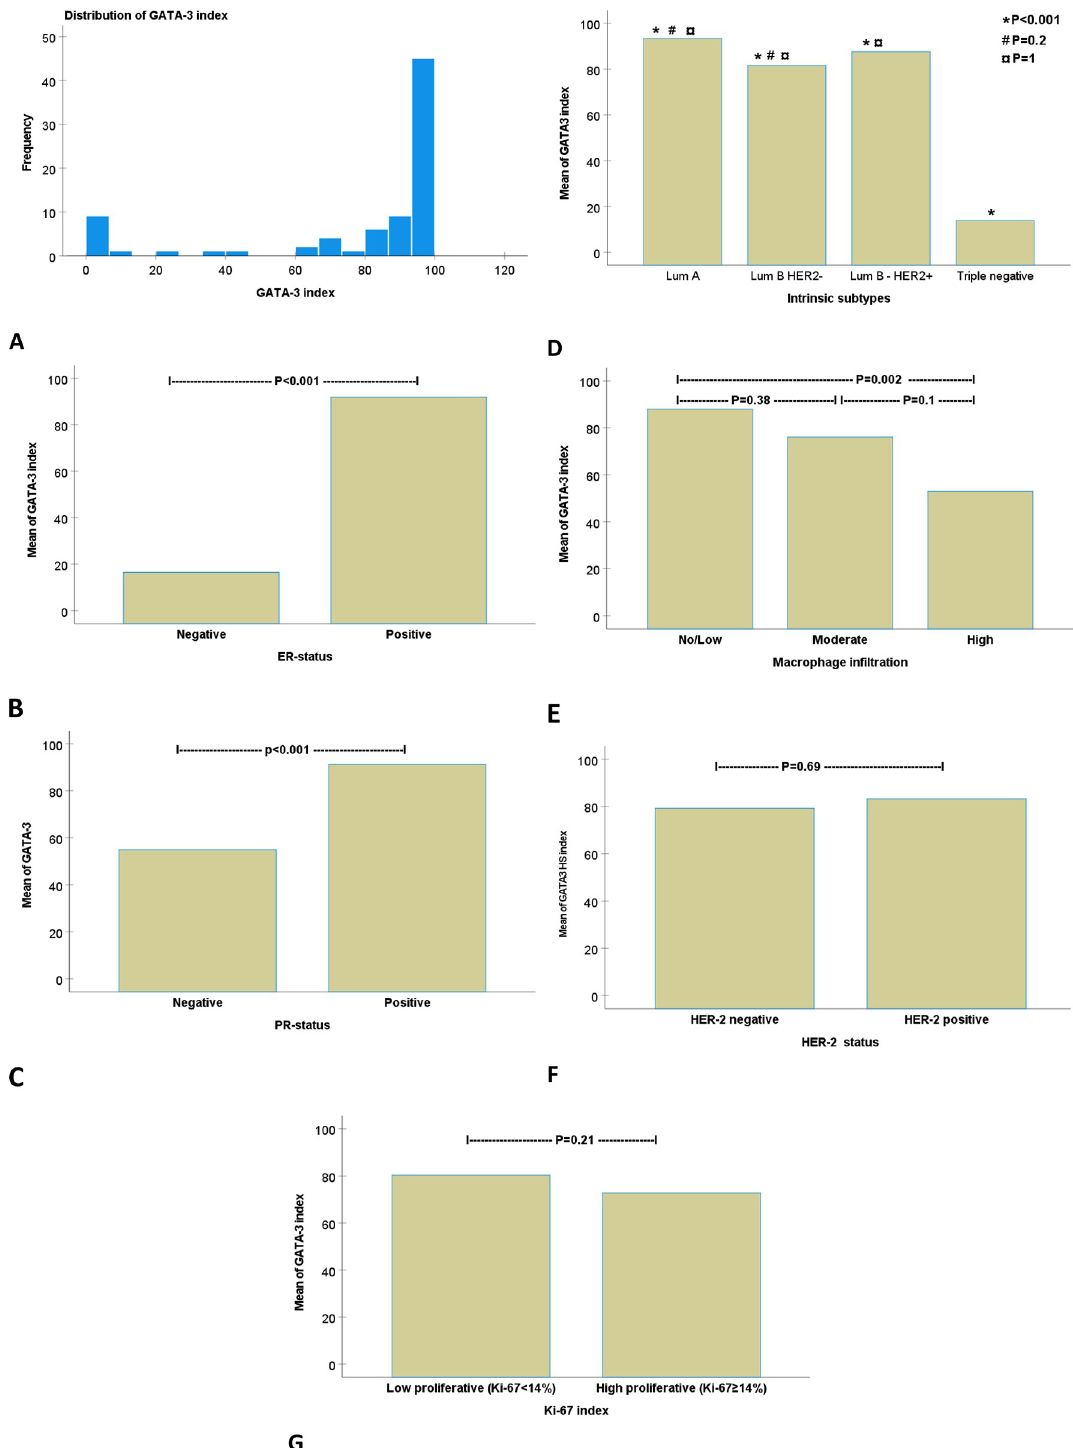
Fig 2. The relation of GATA-3 indexes to macrophage infiltration and functional differentiation of breast cancer. Panel A illustrates the distribution of GATA- 3 indexes. Panels B-G show comparisons of the GATA-3 index in relation to ER status, PR status, intrinsic subtypes, macrophage infiltration, HER-2 status, and Ki-67 index, respectively. For continuous data, one-way analysis of variance (ANOVA) was used with a post-hoc Bonferroni’s test for comparing the means between several than two variables. Mann- Whitney test for comparing the means between two